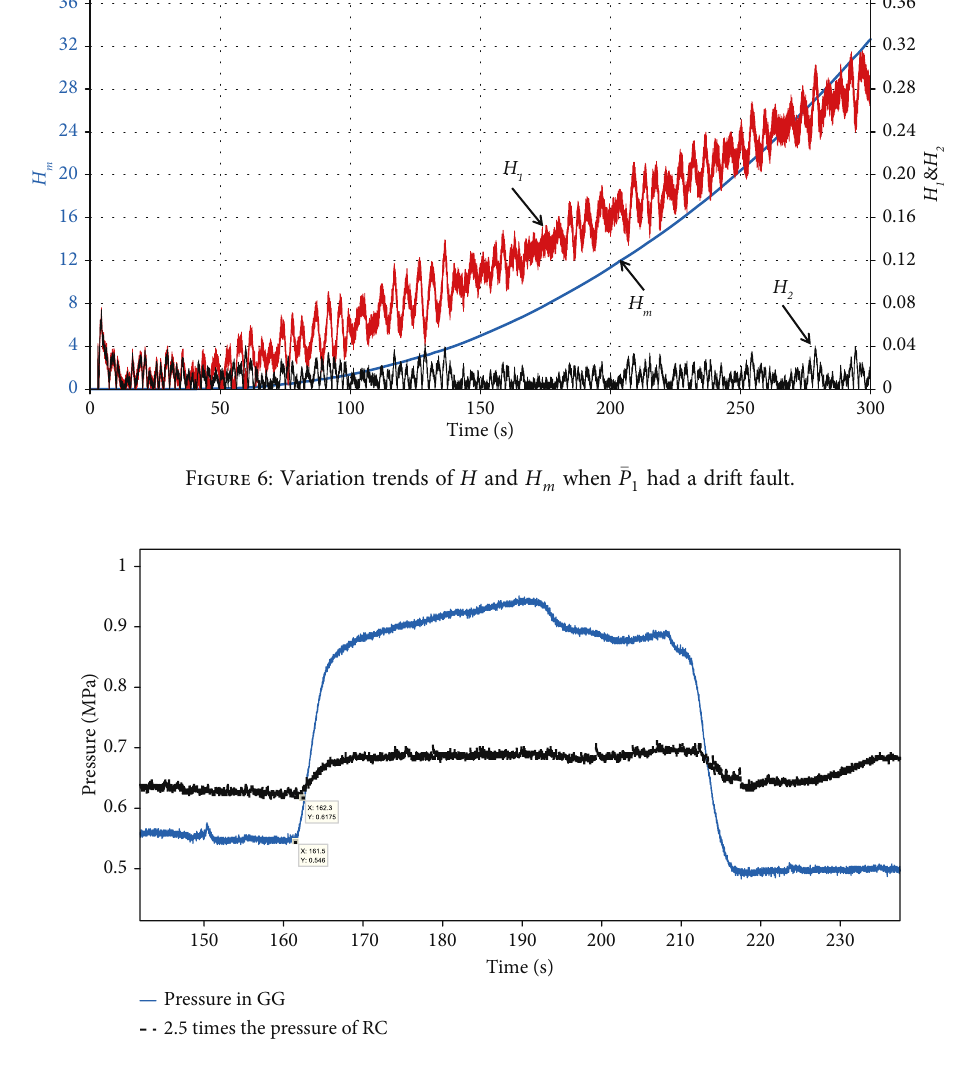
Figure 7: The time delay between the pressure response of the GG and the RC.